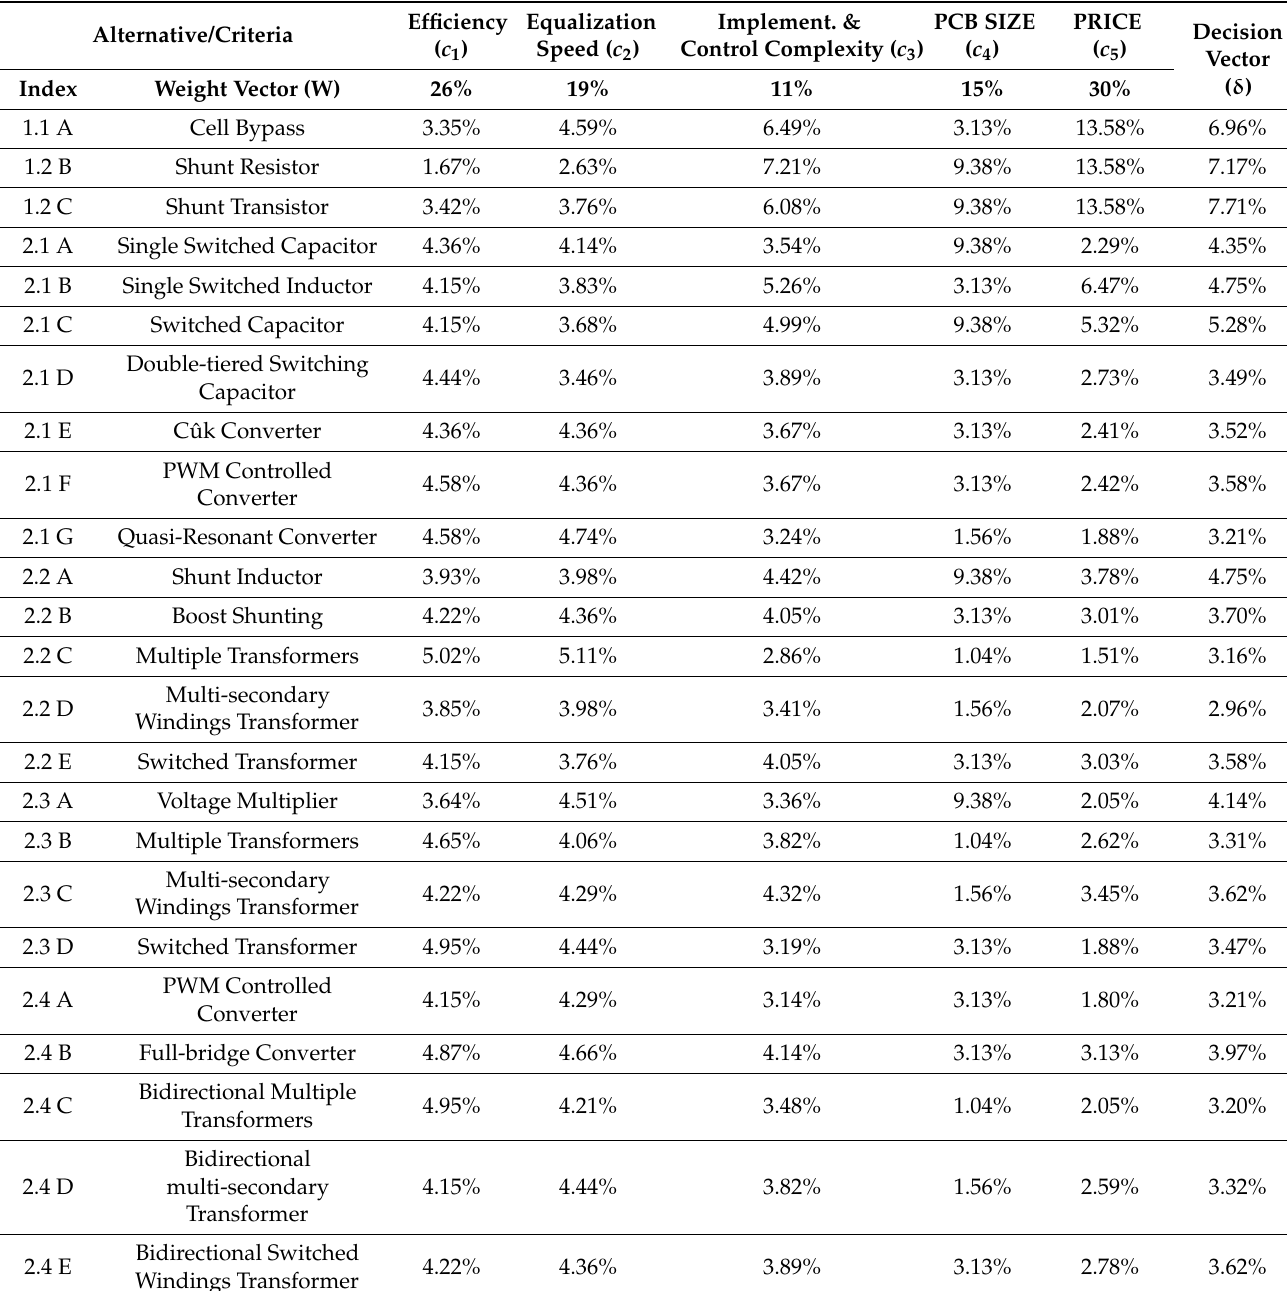
Table 10. Decision profile matrix ( δ